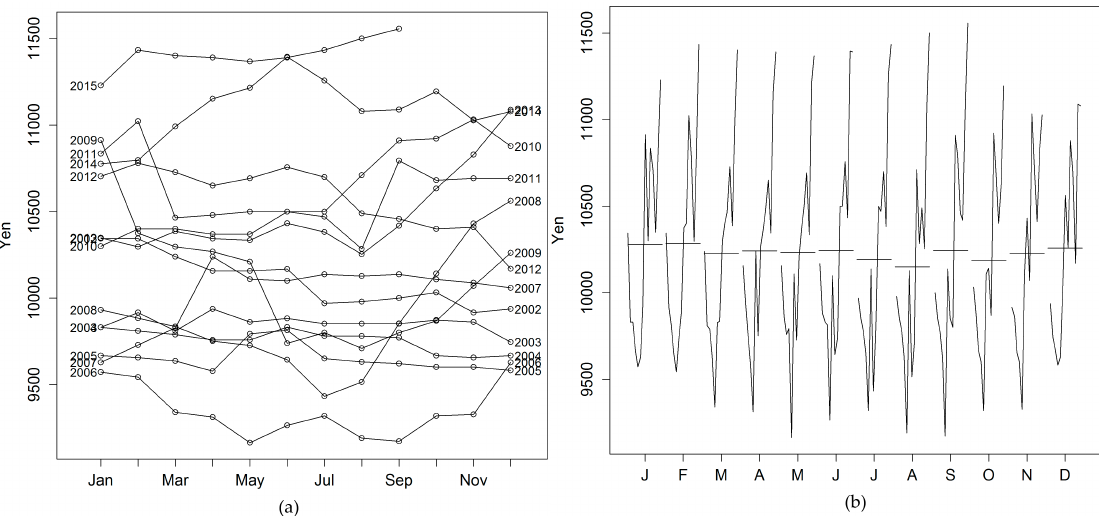
Figure 4. Annual and monthly karamatsu log prices: ( a ) Annual changes of karamatsu log prices against months; ( b ) monthly subseries of karamatsu log prices. The horizontal bars show the mean price for the monthly subseries, and polygonal lines show the changes over the years from 2002 to 2015.